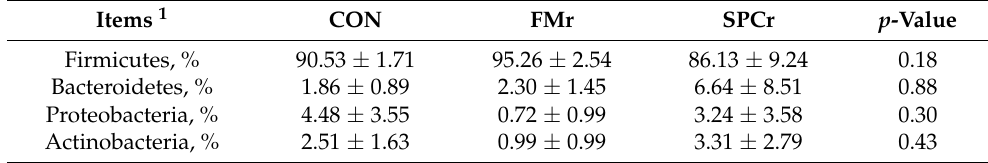
Figure 1. Richness, diversity, and similarity of bacterial communities between different dietary treatments in weaned pigs. Venn diagram of the OTUs in CON, FMr and SPCr groups ( A ). Bacterial diversity was estimated by the Shannon index ( B ). Bacterial richness was estimated by the Chao index ( C ). The principal component analysis (PCA) of samples in the bacterial community among the three groups ( D ). * represents a significant difference ( p < 0.05). Table 6. Differences in the cecum digesta microbiota composition at phylum